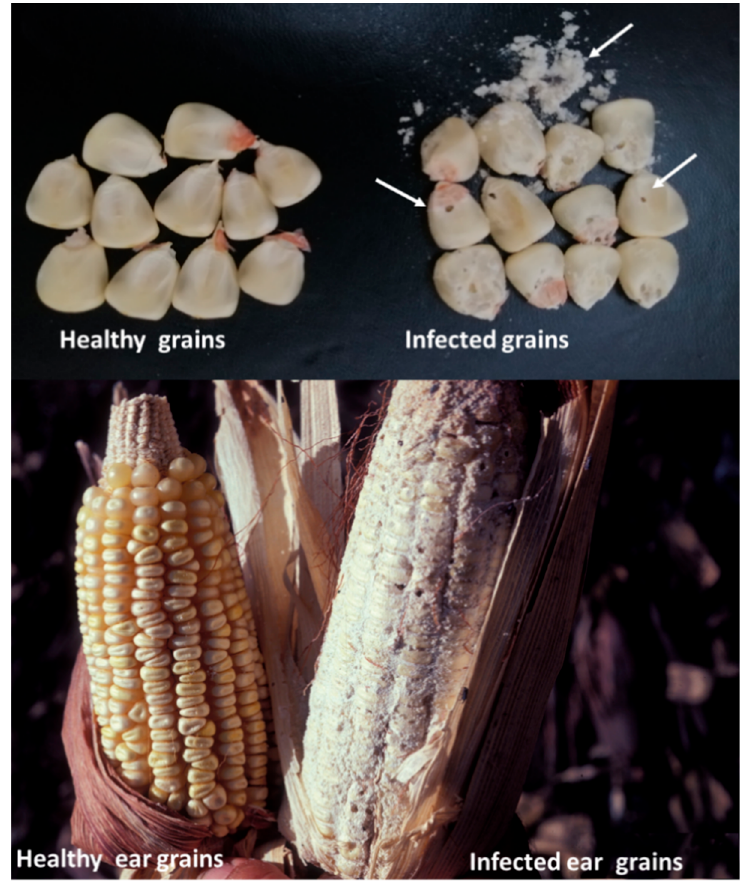
Figure 5. Difference between healthy and infected maize grains used in the current study.